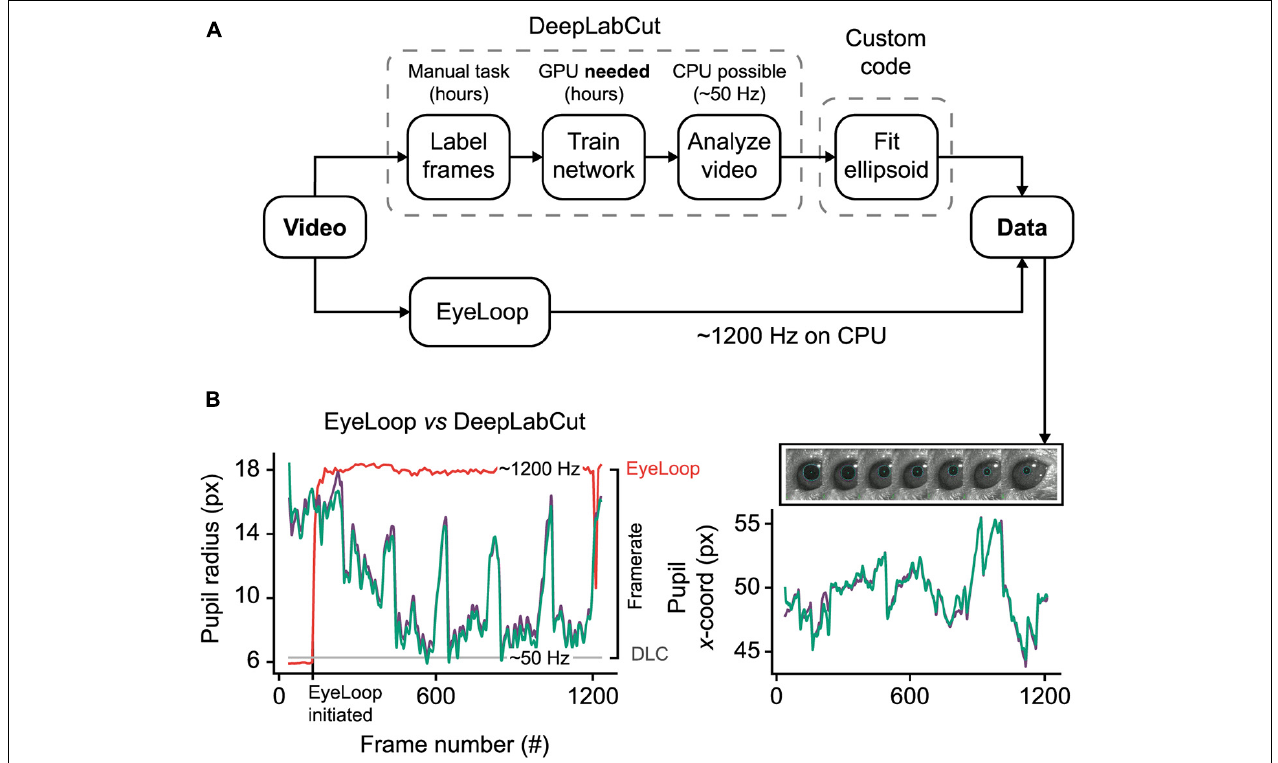
FIGURE 2 | EyeLoop compared to DeepLabCut eye-tracking. (A) Schematic comparison. DeepLabCut requires several steps of setup before tracking can be initiated. Eye-tracking using DeepLabCut on the CPU is limited to ∼ 50 Hz. In contrast, EyeLoop requires minimal setup and runs at speeds greater than 1,000 Hz on the CPU. (B) Data comparison. EyeLoop and DeepLabCut produce similar data despite a significant gap in computational load. Green and purple lines are EyeLoop and DeepLabCut data, respectively. Red and gray lines are EyeLoop’s and DeepLabCut’s framerate,